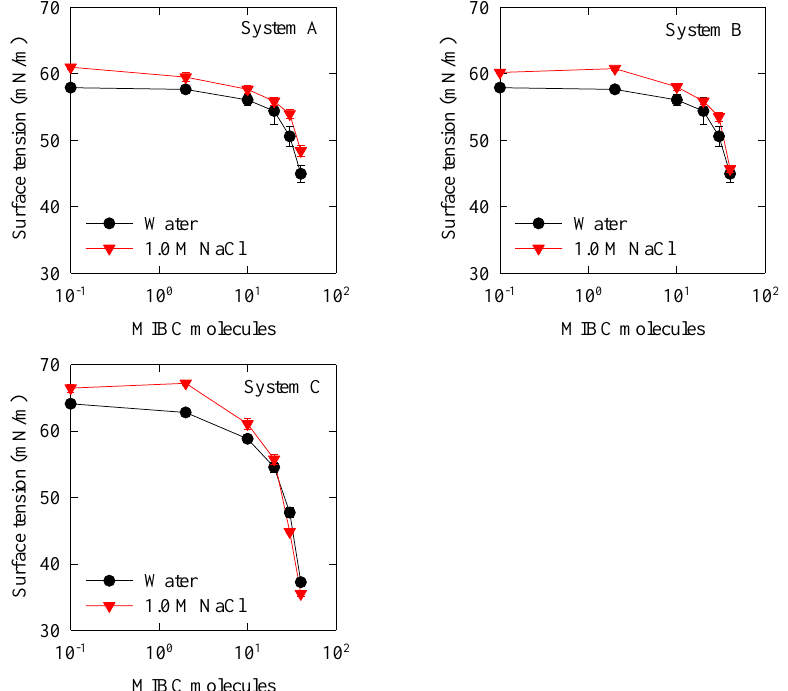
Figure 7. Surface tension versus concentration of MIBC in water and 1.0 M NaCl aqueous solution. Comparison of simulation results for the three systems of interest (Table 2).